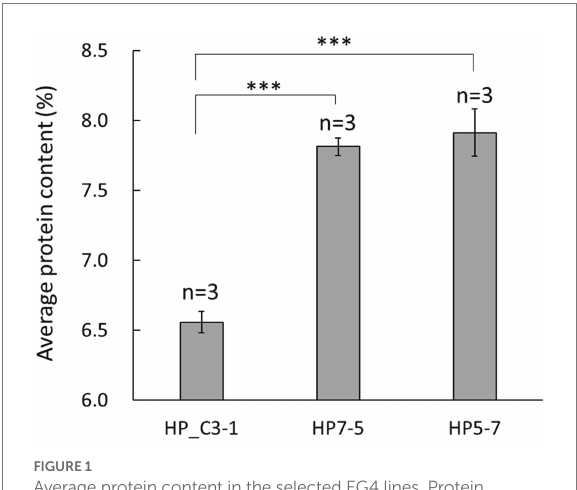
FIGURE 1 Average protein content in the selected EG4 lines. Protein content was evaluated using three independent plants per line. Data shown are the mean ± SD of three replicates ( n = 3). A statistically significant difference between the mean values was inferred from Student’s t -test ( *** p < 0.001).